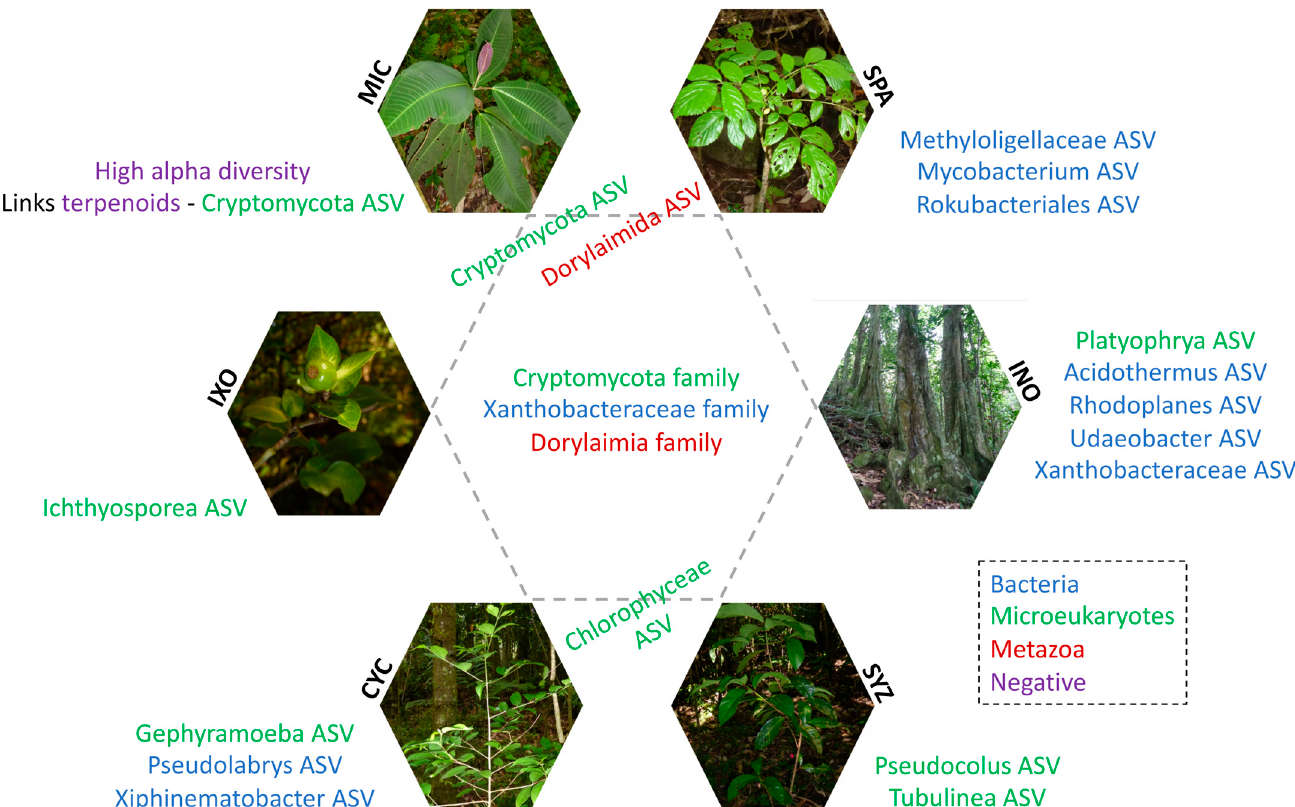
Figure 10. Specific and common features of the six plant species in the tree stage. CYC: Cyclophyllum barbatum , INO: Inocarpus fagifer , IXO: Ixora mooreensis , MIC: Miconia calvescens , SPA: Spathodea cam- panulata , SYZ: Syzygium malaccense . ASV: amplicon sequence variant. Specific features are indicated outside of the central hexagon. Common features are in the center of the central hexagon. Specific features shared between two (Chlorophyceae and Dorylaimida ASVs) or three (Cryptomycota ASVs) plant species are indicated at the limit of the central hexagon near the corresponding plant species. Features from bacteria, microeukaryotes, metazoans, and the negative mode are indicated in blue, green, red, and purple,